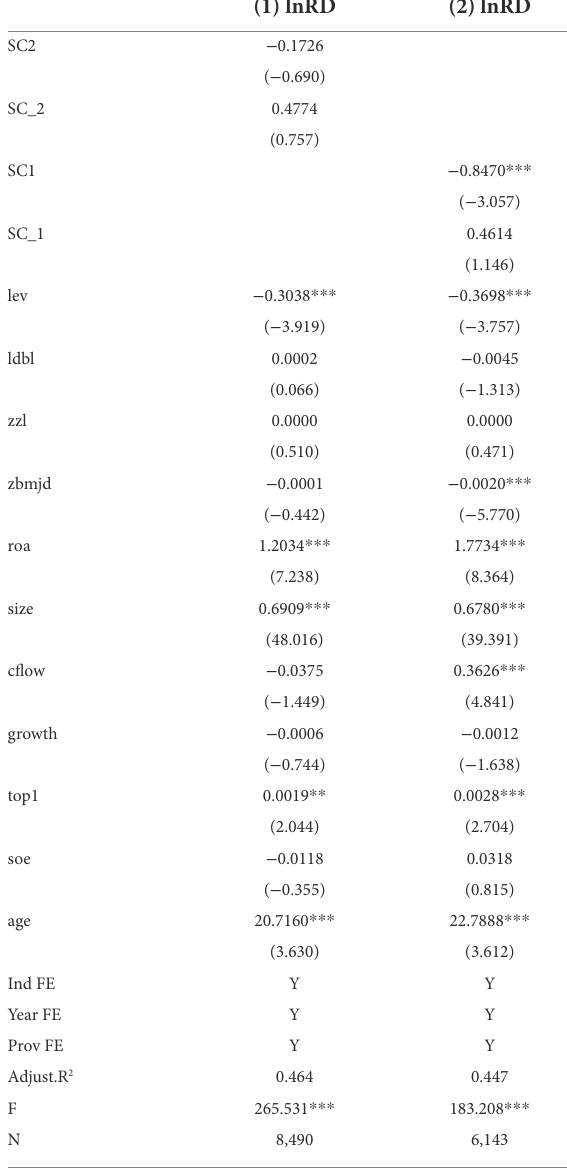
TABLE 9 Robustness